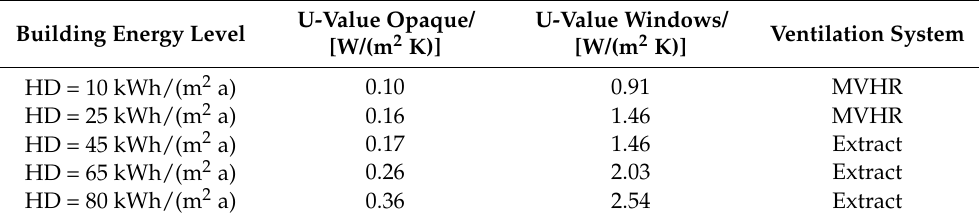
Table 3. Quality of the building envelope and type of ventilation system for the different building energy standards with extract air or mechanical ventilation with heat recovery